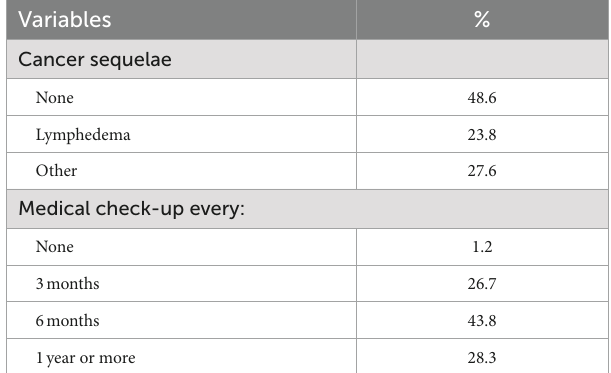
TABLE 2 Sociodemographic and clinical characteristics of the sample ( N =